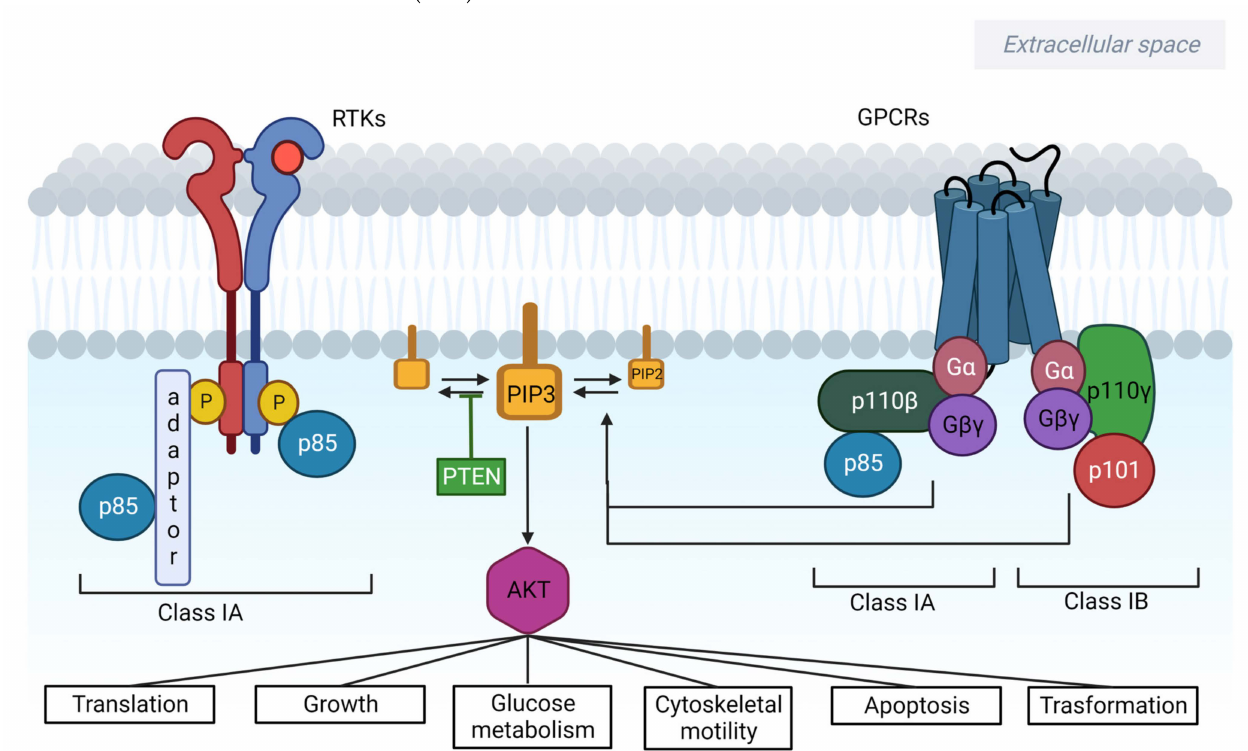
Figure 1. The PI3K/AKT/mTOR pathway is involved in tumorigenesis and cancer progression. After being activated by RTKs, GPCR or RAS, PI3K catalyzes the phosphorylation of PIP2 to generate PIP3, which binds and recruits AKT and PDK1. Furthermore, by activating NF- κ B and inducing the secretion of MMP, AKT promotes cell invasion while increasing the level of cyclin D1, leading to cell cycle progression. Ultimately, Akt promotes cell growth by phosphorylation of the downstream mTORC1, which activates p70S6K-S6 and inhibits 4E-BP1, resulting in protein synthesis and cell growth. Indeed, mTORC2 activates AKT itself. On the other hand, PTEN exerts its role in modu- lating the PI3K pathway by suppressing PIP2 to PIP3 conversion. Together with tuberous sclerosis protein 1 (TSC1) and TSC2, PTEN is the main negative regulator of the pathway. Simultaneously, activation of the growth factor receptor tyrosine kinases and G protein-coupled receptors